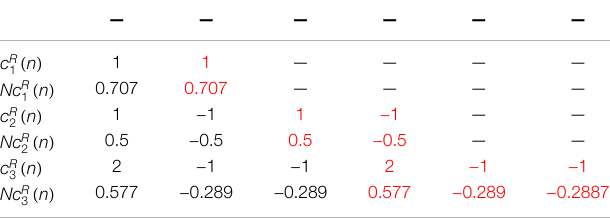
TABLE 1 | The coef fi cients of the RFB ( q ϵ [ 1 , 3 ]) after repetition ( R cq (cid:2) 2 )